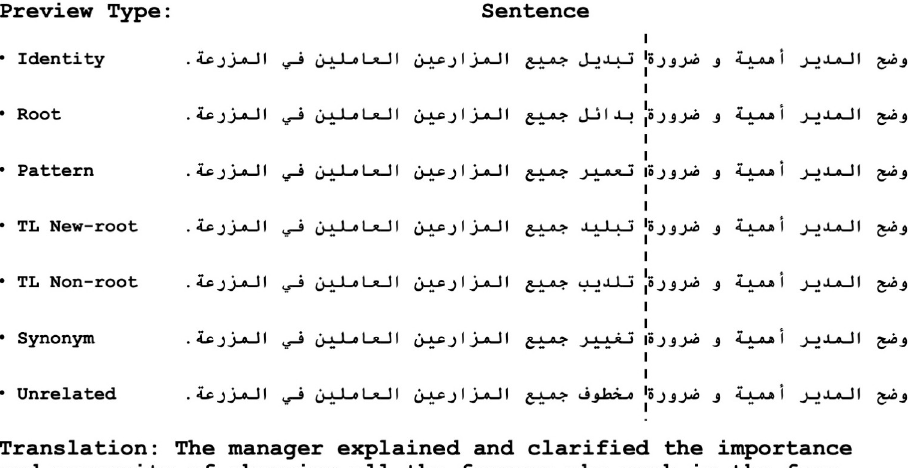
Fig 1. Sample stimuli set. The dashed line indicated the location of the invisible boundary, followed by the different preview strings in the different conditions.